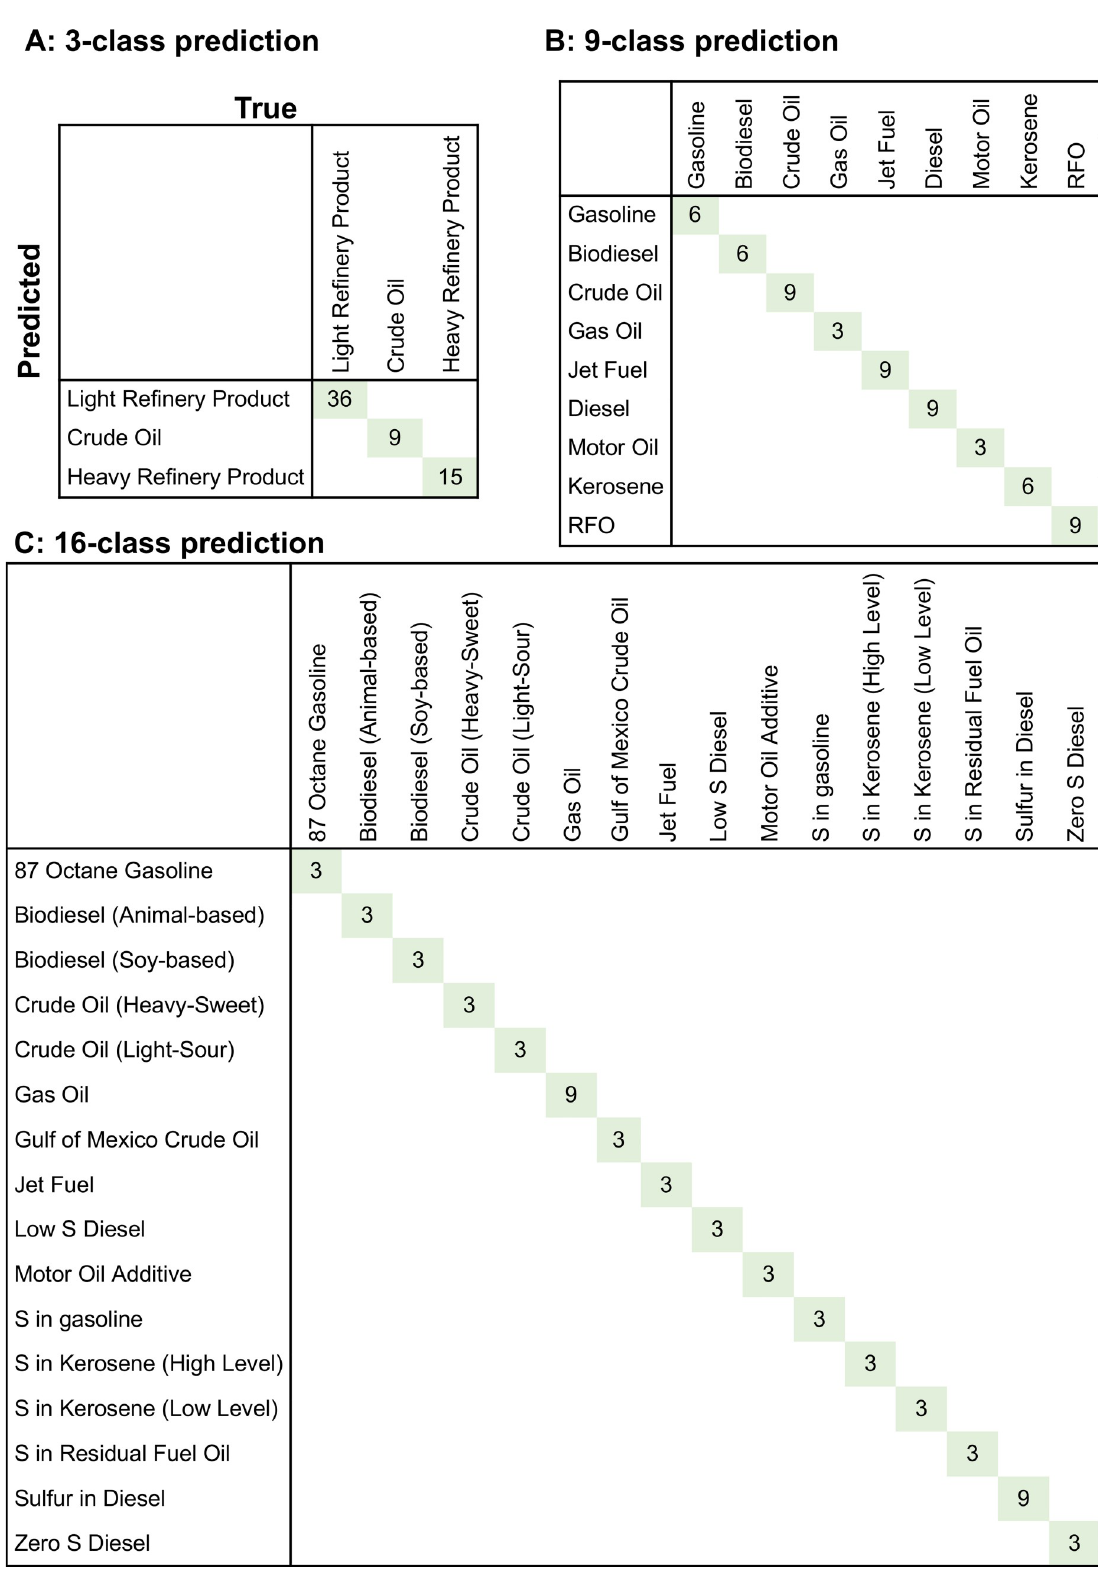
Fig 5. Confusion matrices for SRM sample classification with 3 replicates. (A) 3-class, (B) 9-class, and (C) 16-class grouping.